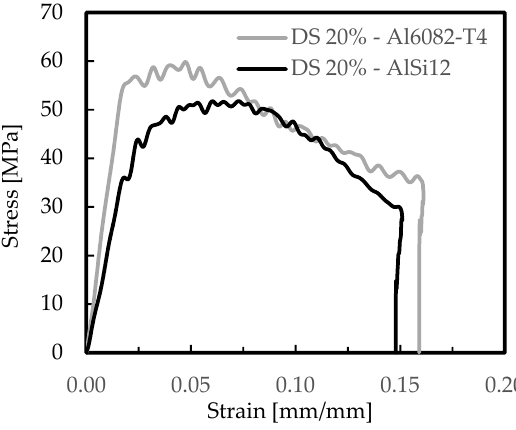
Figure 9. Stress-strain curves for foam-filled tubes.